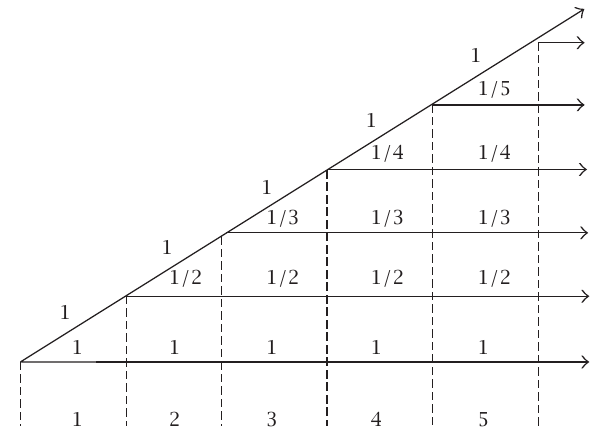
Figure 3.3. State-space diagram for Example 3.14.